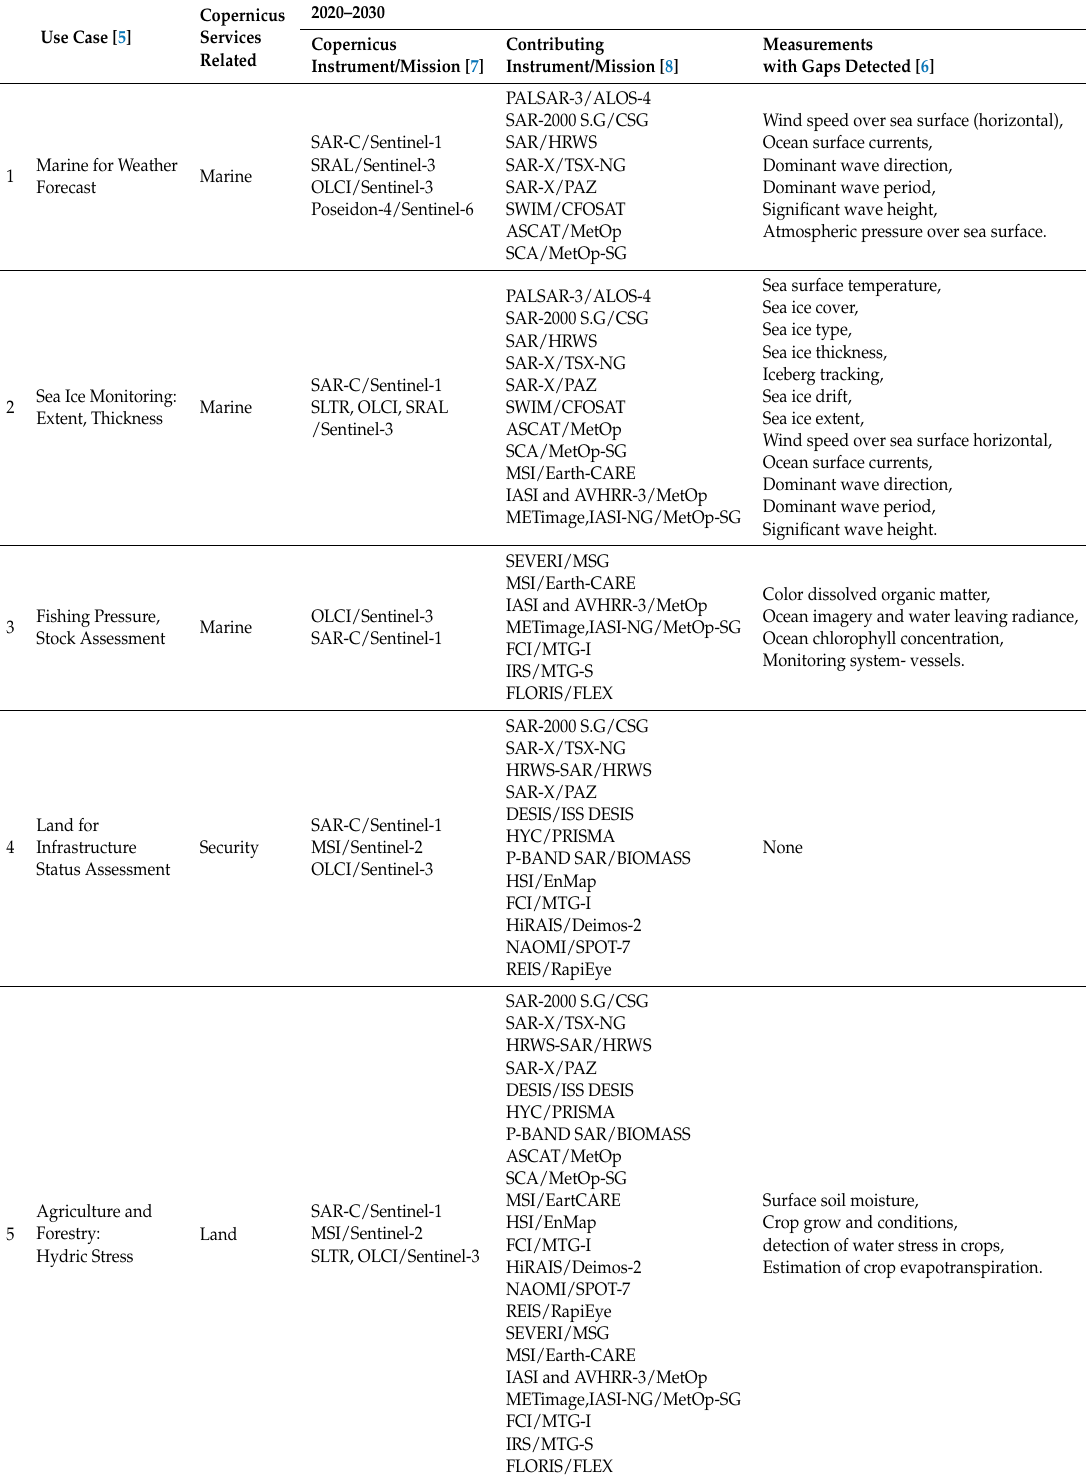
Table 1. The top ten use